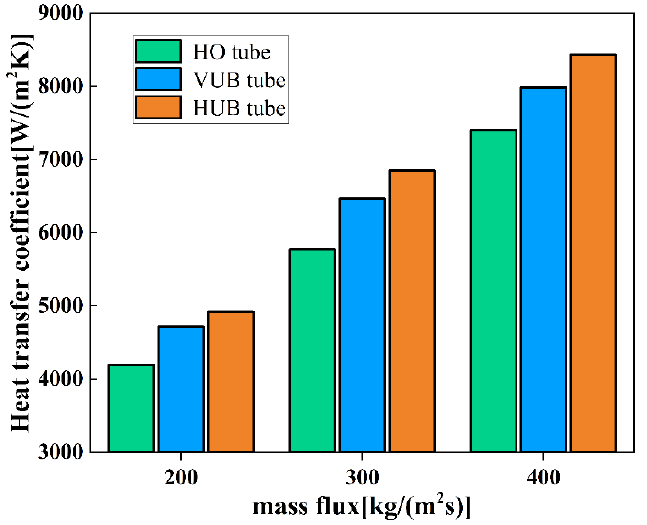
Figure 15. Comparison of the heat transfer coefficients of the three kinds of tubes.